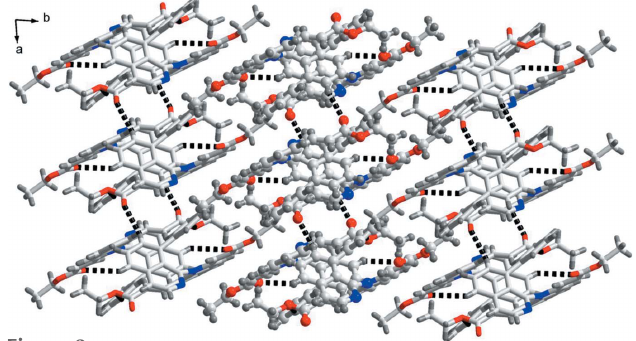
Figure 2 The packing of the title compound showing the two-dimensional layers formed by C—H (cid:3)(cid:3)(cid:3) O hydrogen bonds (dashed lines).